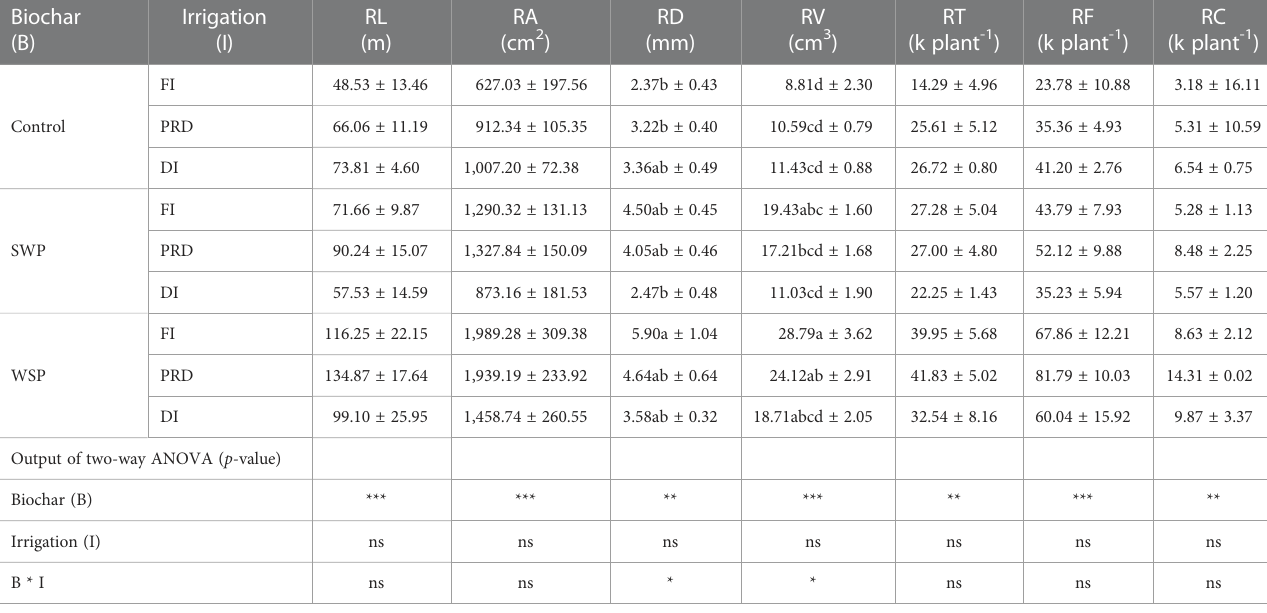
TABLE 2 The effects of treatments and output of two-way ANOVA for total root length (RL), area (RA), diameter (RD), volume (RV), tips (RT), forks (RF), and crossings (RC) of maize plants.